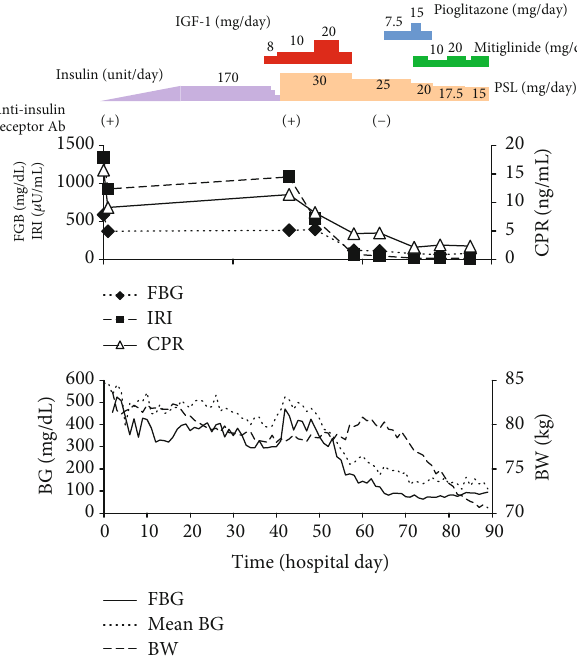
Figure 2: Clinical course of the case. Mean blood glucose was calculated as the average of four measurements (before each meal and sleep (approximately 2h after dinner)). The upper panel shows an outline of treatment, including the daily insulin dose (unit/day), IGF-1 (mg/day), PSL (mg/day), and oral hypoglycemic agents and changes in the anti-insulin receptor antibody. The middle panel shows the transition of FBG, IRI, and CPR, and the lower panel shows the transition of detailed FBG, mean blood glucose, and body weight. BW: body weight; CPR: C-peptide; FBG: fasting blood glucose; IGF-1: insulin-like growth factor-1; IRI: immunoreactive insulin; PSL: prednisolone; Ab: antibody. The blood glucose level above the upper limit of measurement (600mg/dL, 33.3mmol/L) of the self- monitoring blood glucose meter was calculated as 600mg/dL (33.3 mmol/L). Table 3: Changes in mean BG, total BG, insulin dose, and PSL dose before and after starting IGF-1. Hospital